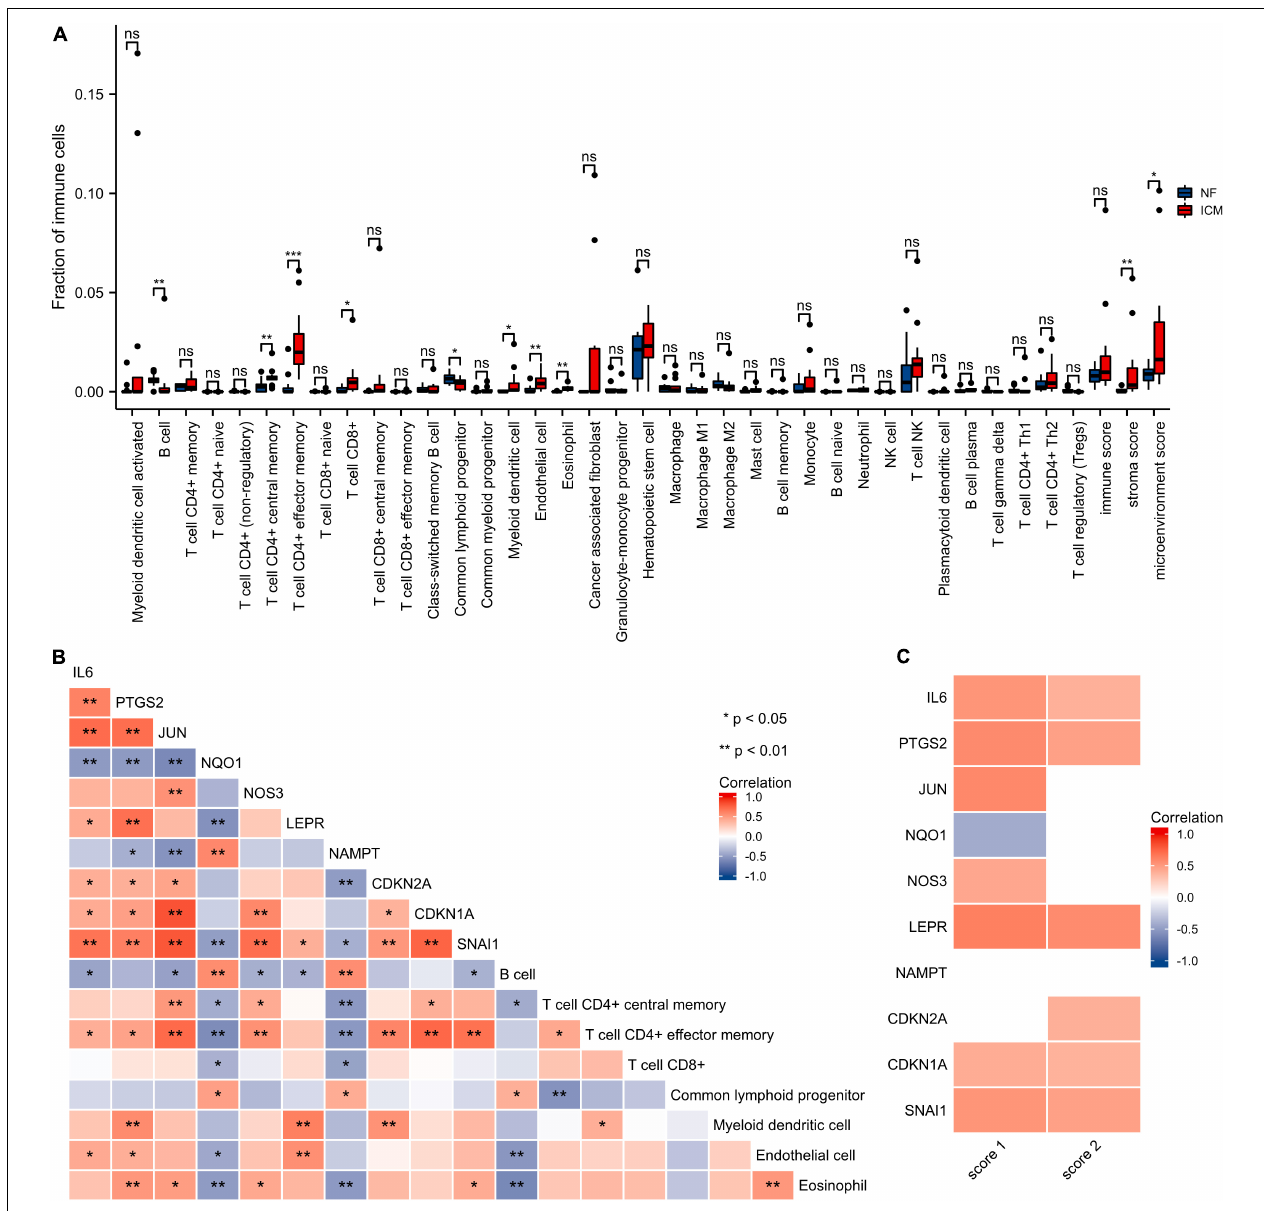
FIGURE 8 | Immune infiltration analysis of the hub genes. (A) The score of the immune cells and stroma in GSE116250 is estimated by the xCell. NF, control group; ICM, ischemic myocardiopathy group. (B) The correlation heatmap of the hub genes and cell types with differential immune scores. Red, positive correlation; blue, negative correlation. (C) The correlation heatmap of the hub genes, stroma score, and microenvironment score. Red, positive correlation; blue, negative correlation; white, p > 0.05. Score 1, stroma score; Score 2, microenvironment score.